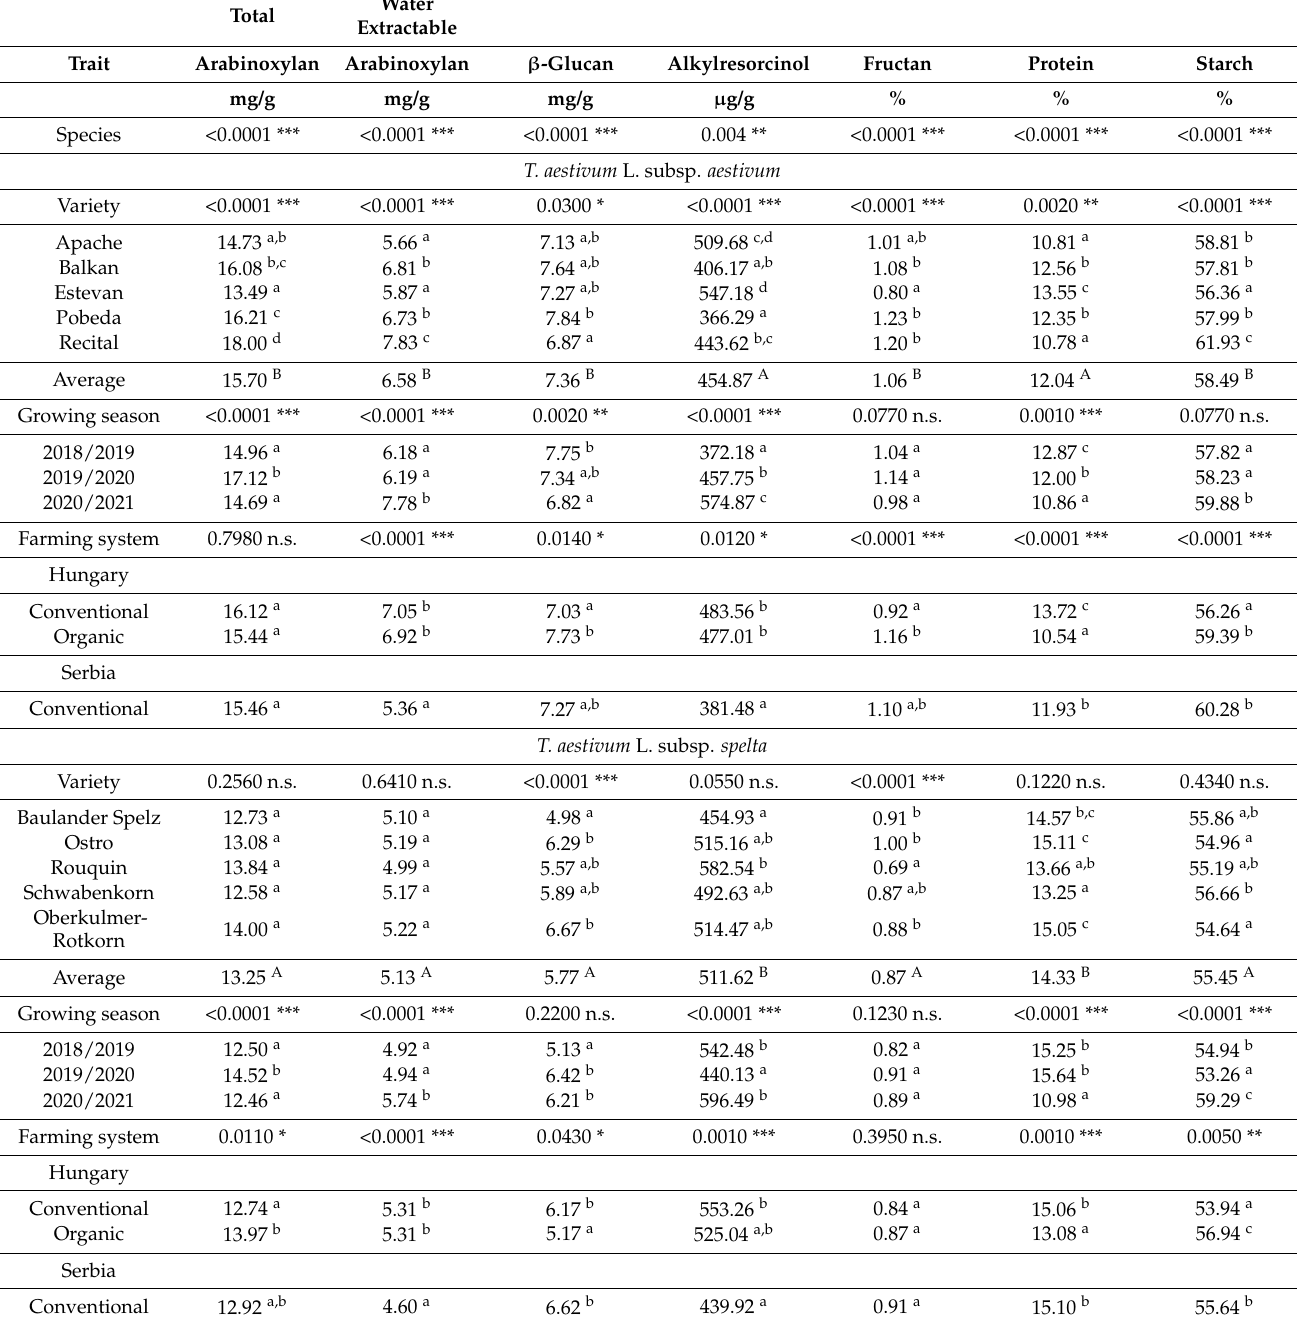
Table 4. Bioactive compound, protein and starch content depending on wheat species, variety, growing season and farming